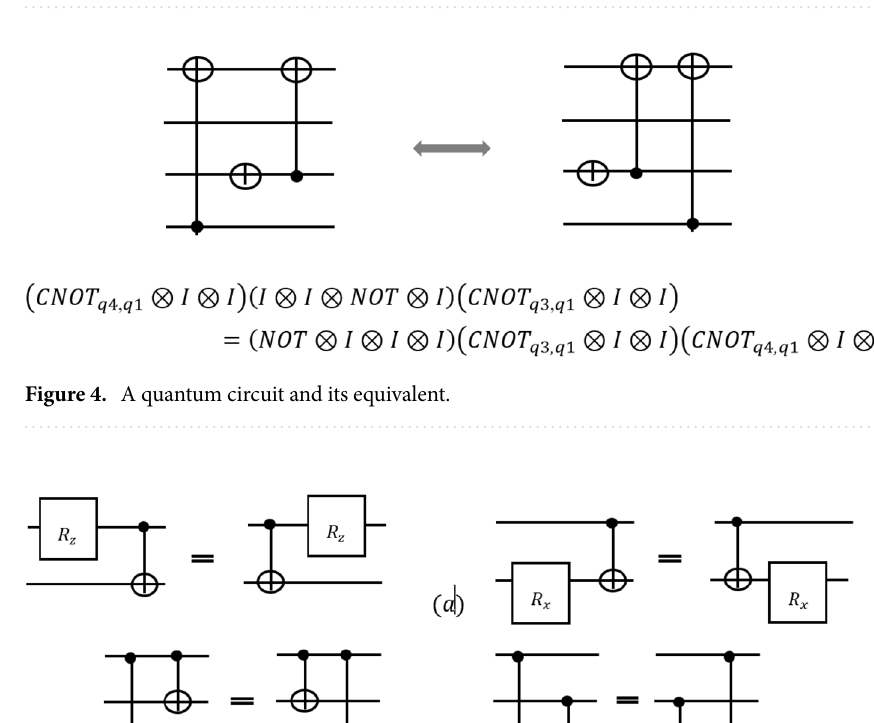
Figure 3. ( a ) Equivalent circuits of Swap gates. ( b ) Equivalent circuits of Bridge gates 38 .